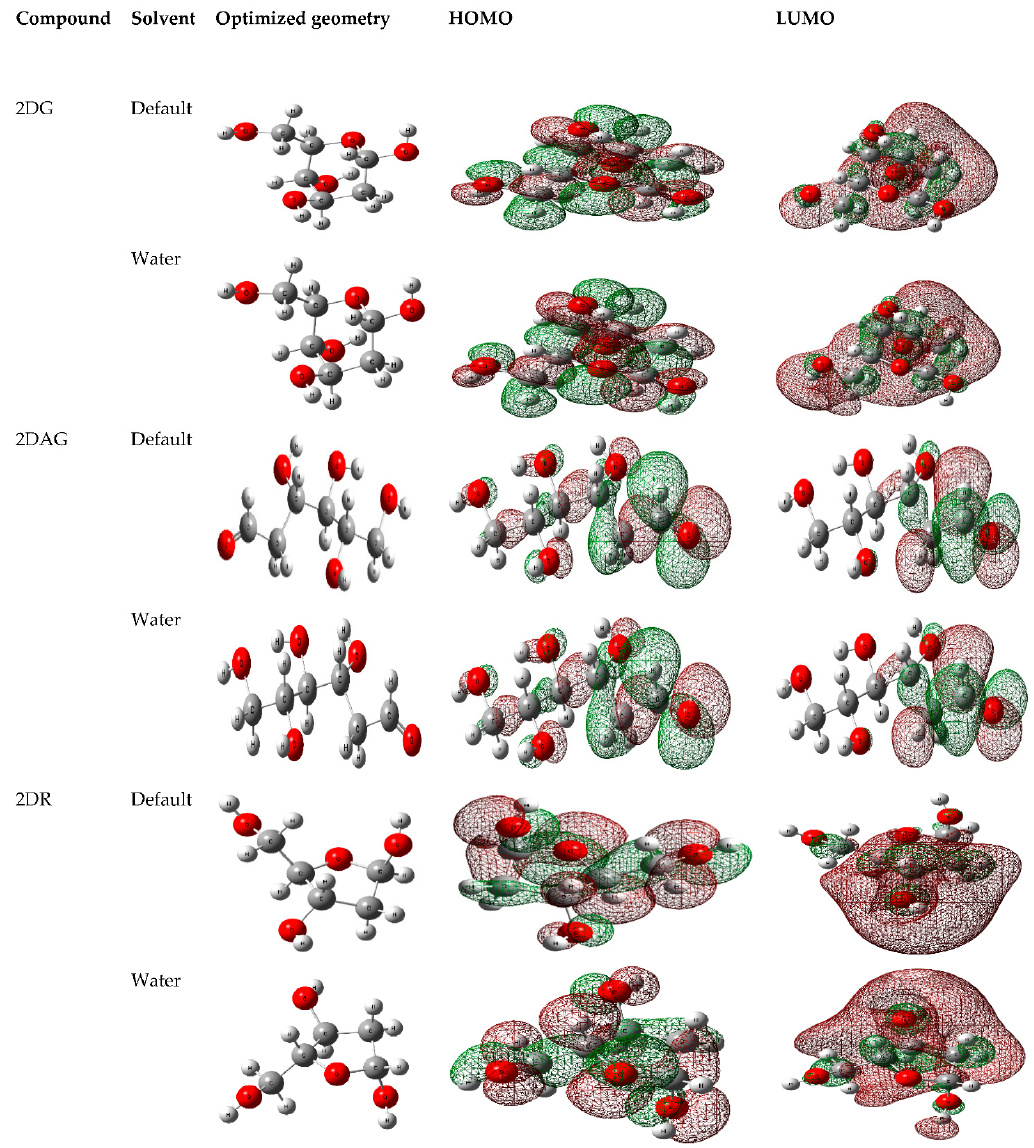
Figure 2. Optimized structures, HOMO and LUMO of 2-deoxy-D-glucose (2DG), 2-deoxy-glucose (2DAG) and 2-deoxy-D-ribose (2DR).